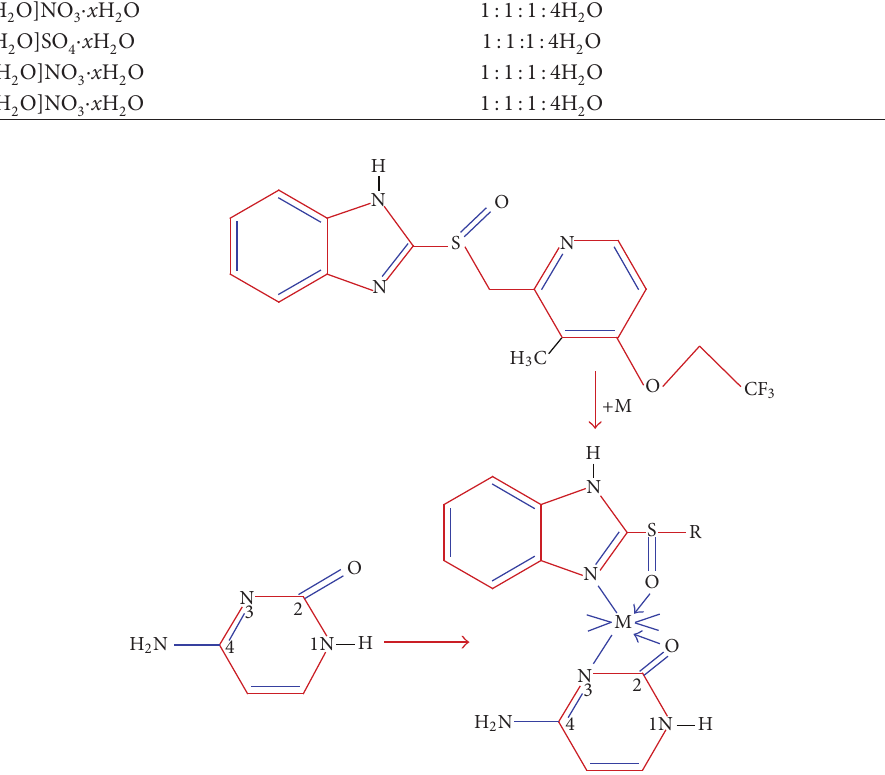
F 1: Proposed Scheme and Structure of representative ternary complex